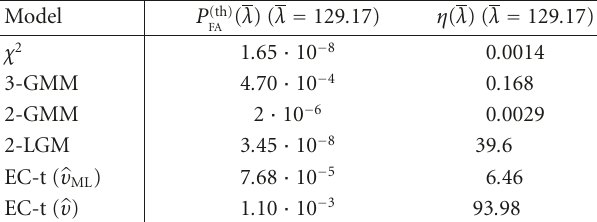
Table 6: Second column: values of the P FA predicted by using each theoretical model when the RX detector is applied to class no.2 data and detection is accomplished with a test threshold λ = 129 . 17. Third column: percentage of the P FA obtained by applying the RX detector to class no.2 data addressed by each theoretical